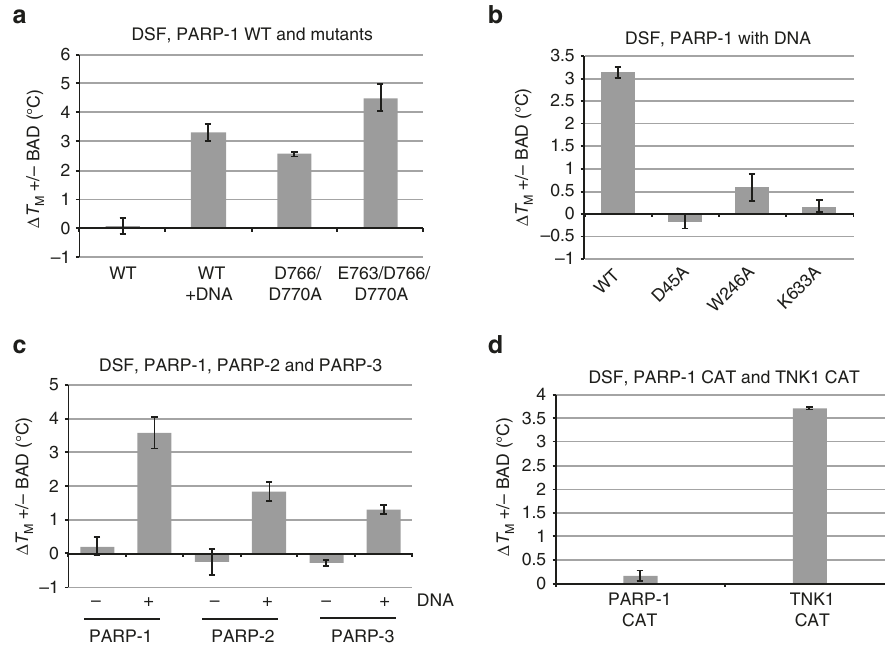
Fig. 3 PARP-1 binds NAD + analog BAD only in the presence of DNA or when obstructing residues are removed. a, b DSF experiment using full-length PARP-1 WT or mutants (5 μ M) in the presence or absence of DNA (2.5 μ M, 26-bp duplex) and BAD (1250 μ M). The Δ T M is calculated by subtracting the T T M obtained in the absence of compound from the M obtained in the presence of compound. c DSF experiment using full-length PARP-1, PARP-2, and PARP-3 (5 μ M) in the absence and presence of DNA (2.5 μ M, PARP-1: 28-bp duplex, PARP-2: 28-bp duplex 5 ’ P, PARP-3: 47-bp duplex with a central 5 ’ P nick) and BAD (1250 μ M). d DSF experiment using the CAT domains of PARP-1 and Tankyrase 1 (5 μ M) with BAD (4 mM). The Δ T M is calculated by subtracting the T M obtained in the absence of BAD from the T M obtained in the presence of BAD. The experiments were performed in triplicate and the averages and standard deviations are